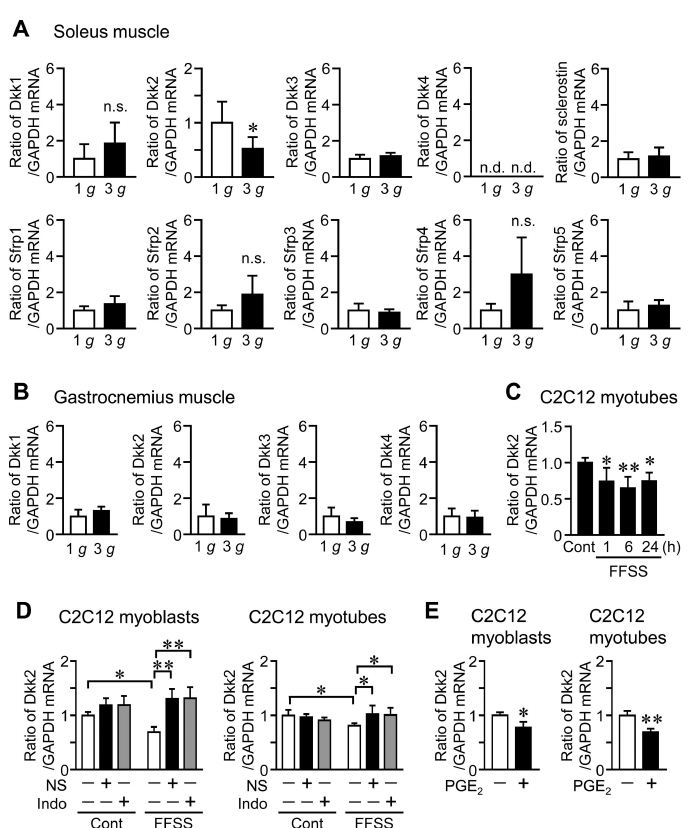
Figure 2. E ff ects of hypergravity on the levels of canonical Wnt / β -catenin signaling-related factors in the skeletal muscle of mice. ( A , B ) Total RNA was extracted from the soleus ( A ) and gastrocnemius ( B ) muscles of mice with exposure to 1 g or 3 g for 4 weeks ( n = 8 mice in each group). Then, real-time PCR analysis of Dkk1, Dkk2, Dkk3, Dkk4, sclerostin, Sfrp1, Sfrp2, Sfrp3, Sfrp4, Sfrp5 or GAPDH was performed. Data represent the mean ± SD of eight mice in each group. * p < 0.05 vs. 1 g mice (Mann-Whitney U test). n.s., no significant di ff erence. ( C ) Myoblastic C2C12 cells were cultured with Dulbecco’s Modified Eagle’s Medium (DMEM) and 2% horse serum for 5 days for di ff erentiation into myotubes. Total RNA was extracted from C2C12 myotubes after exposure to fluid flow shear stress (FFSS) for 1, 6 or 24 h and static conditions (Cont) ( n = 5 in each group). Then, real-time PCR analysis of Dkk2 or GAPDH was performed. Data represent the mean ± SD of five experiments in each group. ** p < 0.01 and * p < 0.05 vs. control group (Dunnett test). ( D ) Total RNA was extracted from C2C12 myoblasts or myotubes 6 h after exposure to FFSS in the presence ( + ) or absence ( − ) of 10 µ M NS-398 (NS) or 1 µ M indomethacin (Indo), and real-time PCR analysis of Dkk2 or GAPDH was performed ( n = 6 in each group). Data represent the mean ± SD of six experiments in each group. ** p < 0.01 and * p < 0.05 (Tukey-Kramer test). ( E ) Total RNA was extracted from C2C12 myoblasts or myotubes cultured with ( + ) or without ( − ) 1 µ M PGE 2 for 24 h ( n = 6 in each group). Real-time PCR analysis of Dkk2 or GAPDH was performed. Data represent the mean ± SD of six experiments in each group. ** p < 0.01 and ** p < 0.05 (Mann-Whitney U